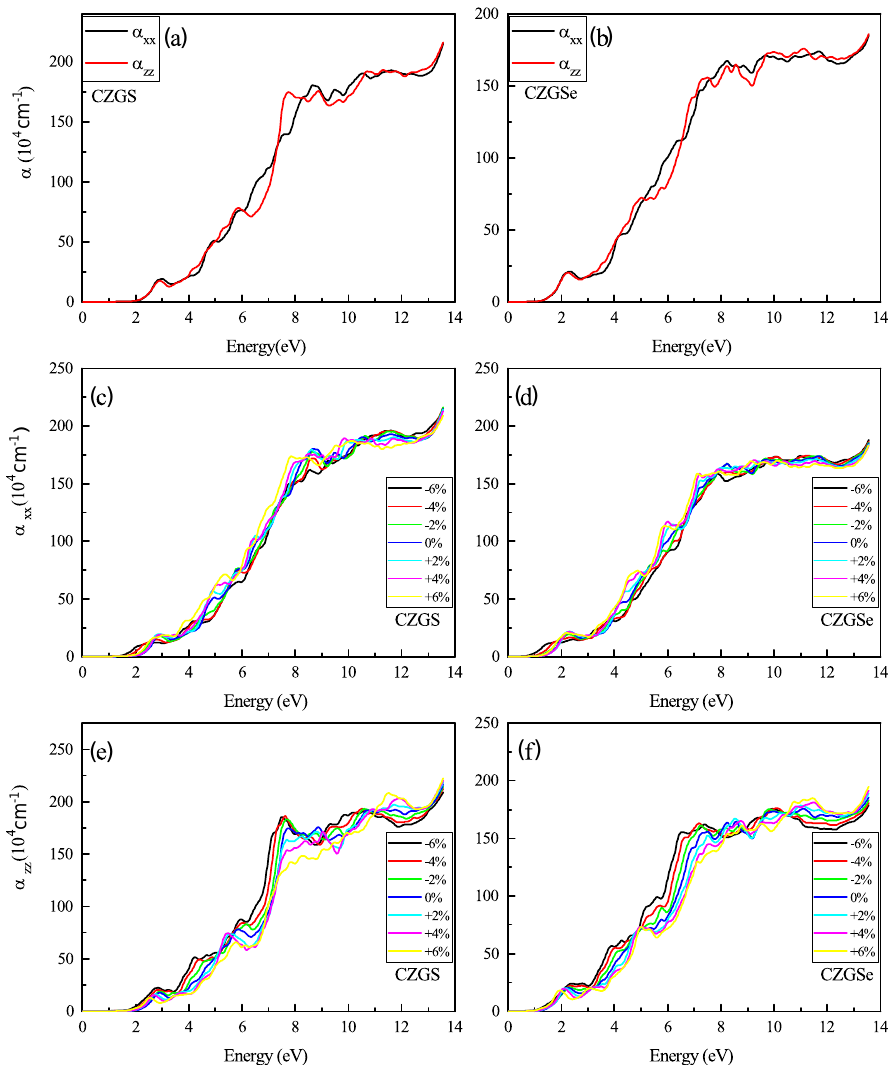
Figure 10. The variation of the absorption coefficient spectra as a function of the incident pho- ton energy for both materials CZGS and CZGSe: ( a , b ) are the unstrained cases, ( c – f ) are the strained cases. α xx and α zz are the absorption coefficients for light polarization along XX and ZZ directions